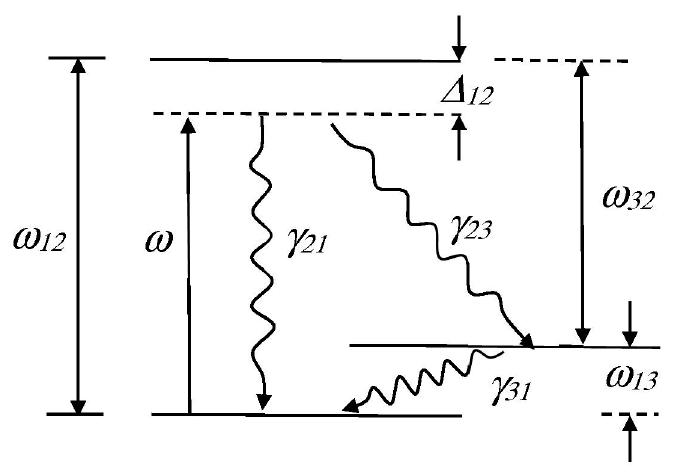
Figure 7. 3-level system with dipole-allowed transitions between states 1 and 2 and between states 2 and 3. State 3 is assumed to be metastable. The frequency of incident light is ω